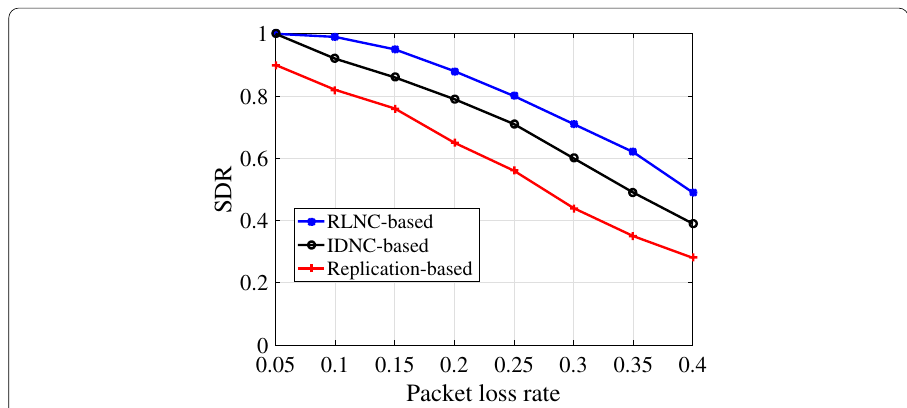
Fig. 11 The relation between packet loss rate and SDR of the device